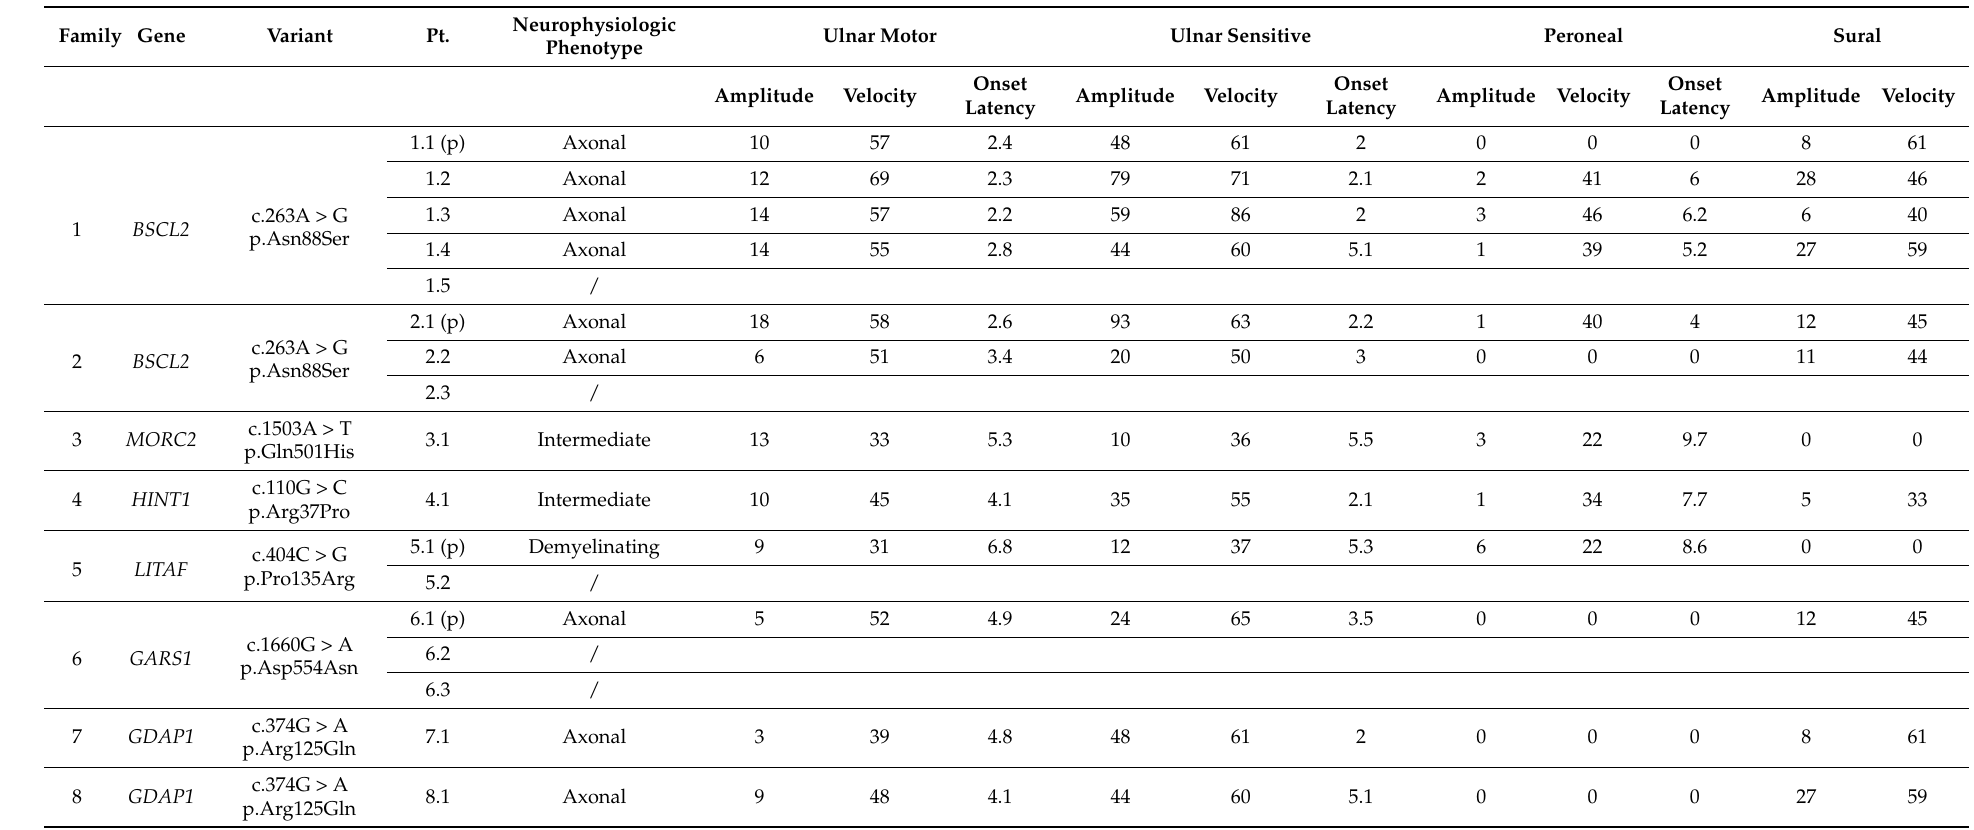
Table 4. Neurophysiological studies of 12/17